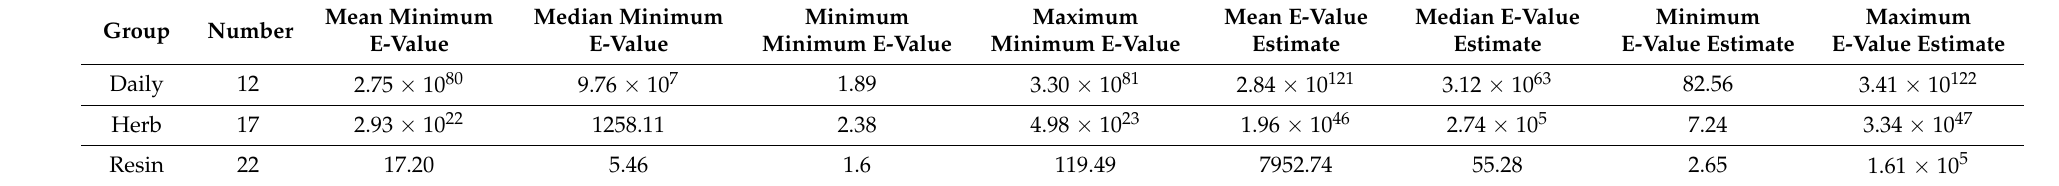
Table 14. Summary of E-Values by Major